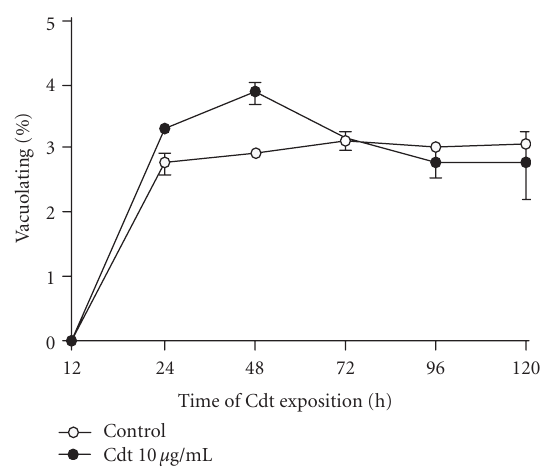
Figure 4. Vacuole formation. Peritoneal macrophages were ob- tained and exposed in vitro to 10 µ g/mL of Cdt as described in “materials and methods.” After di ff erent periods of incubation at 37 ◦ C in an atmosphere of 5% CO 2 , the cells were stained with neutral red for 5 minutes. The absorbance was determined at 540nm, and the results were expressed as described before. Each point represents the mean value of samples from five ex- periments in di ff erent groups of five mice. Statistical di ff erences between the treatments were P > .